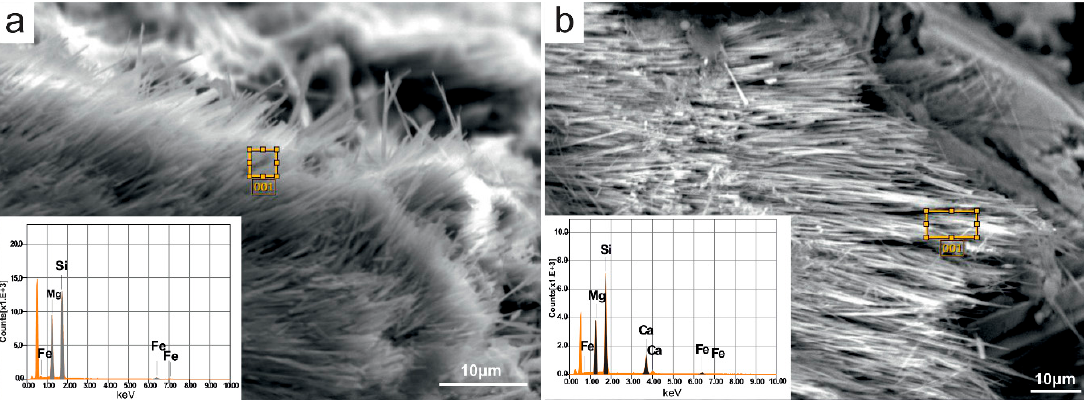
Figure 5. Scanning electron microscopy (SEM) images of asbestos. ( a ) Chrysotile sample E11; and ( b ) tremolite sample E4. Graphical inserts depict energy dispersive spectrometry (EDS) point analysis.